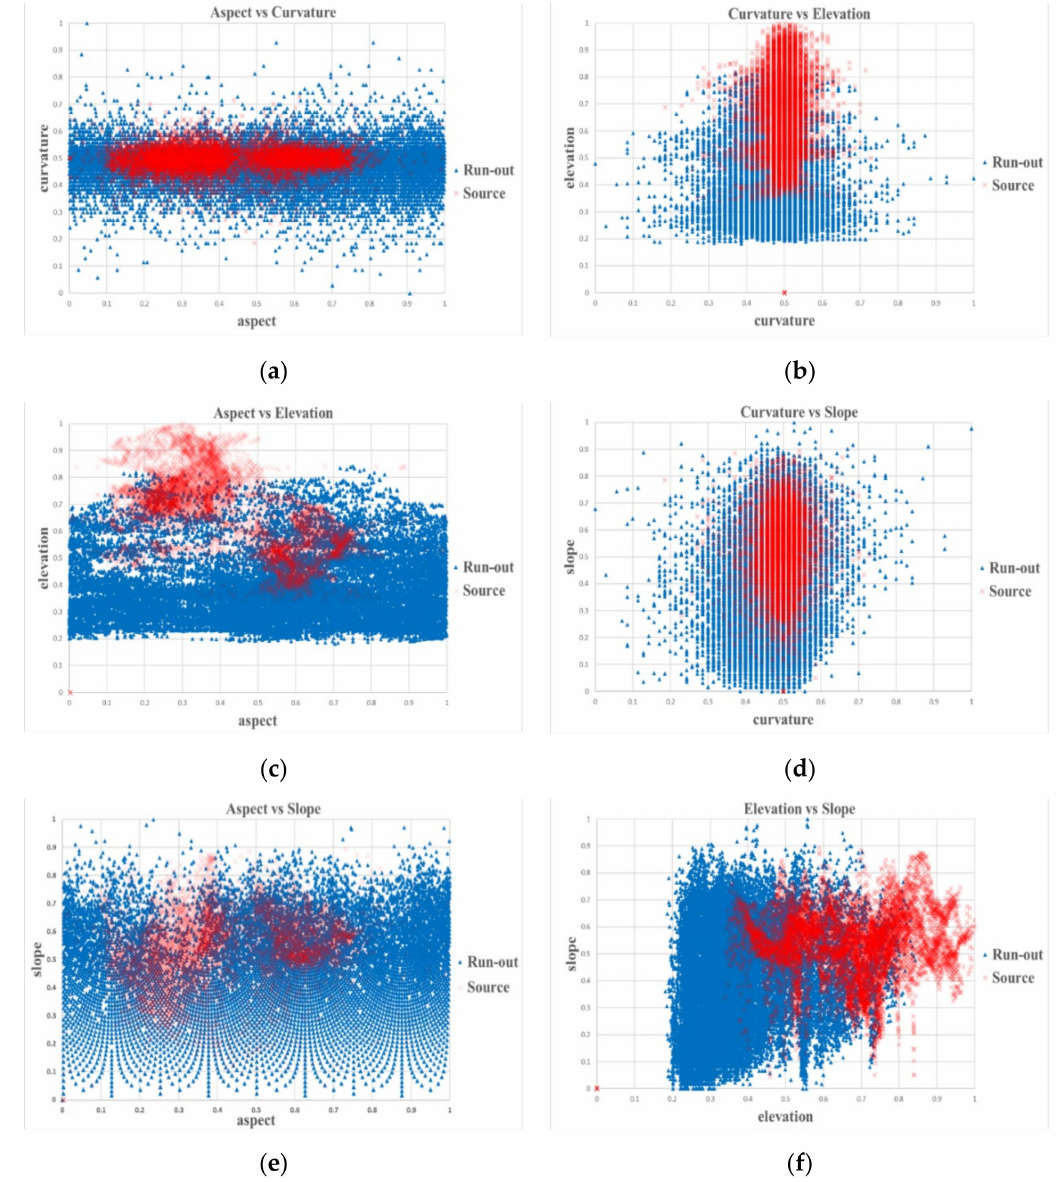
Figure 4. Patterns for comparing aspect, curvature, elevation, and slope layers with the samples extracted from the inventory polygon with an area of ≥ 100,000 m 2 , where red and blue dots represent the landslide source and runout classes, respectively. ( a ): Aspect vs. curvature.; ( b ): curvature vs. elevation; ( c ): aspect vs. elevation; ( d ): curvature vs. slope; ( e ): aspect vs. slope; ( f ): elevation vs.